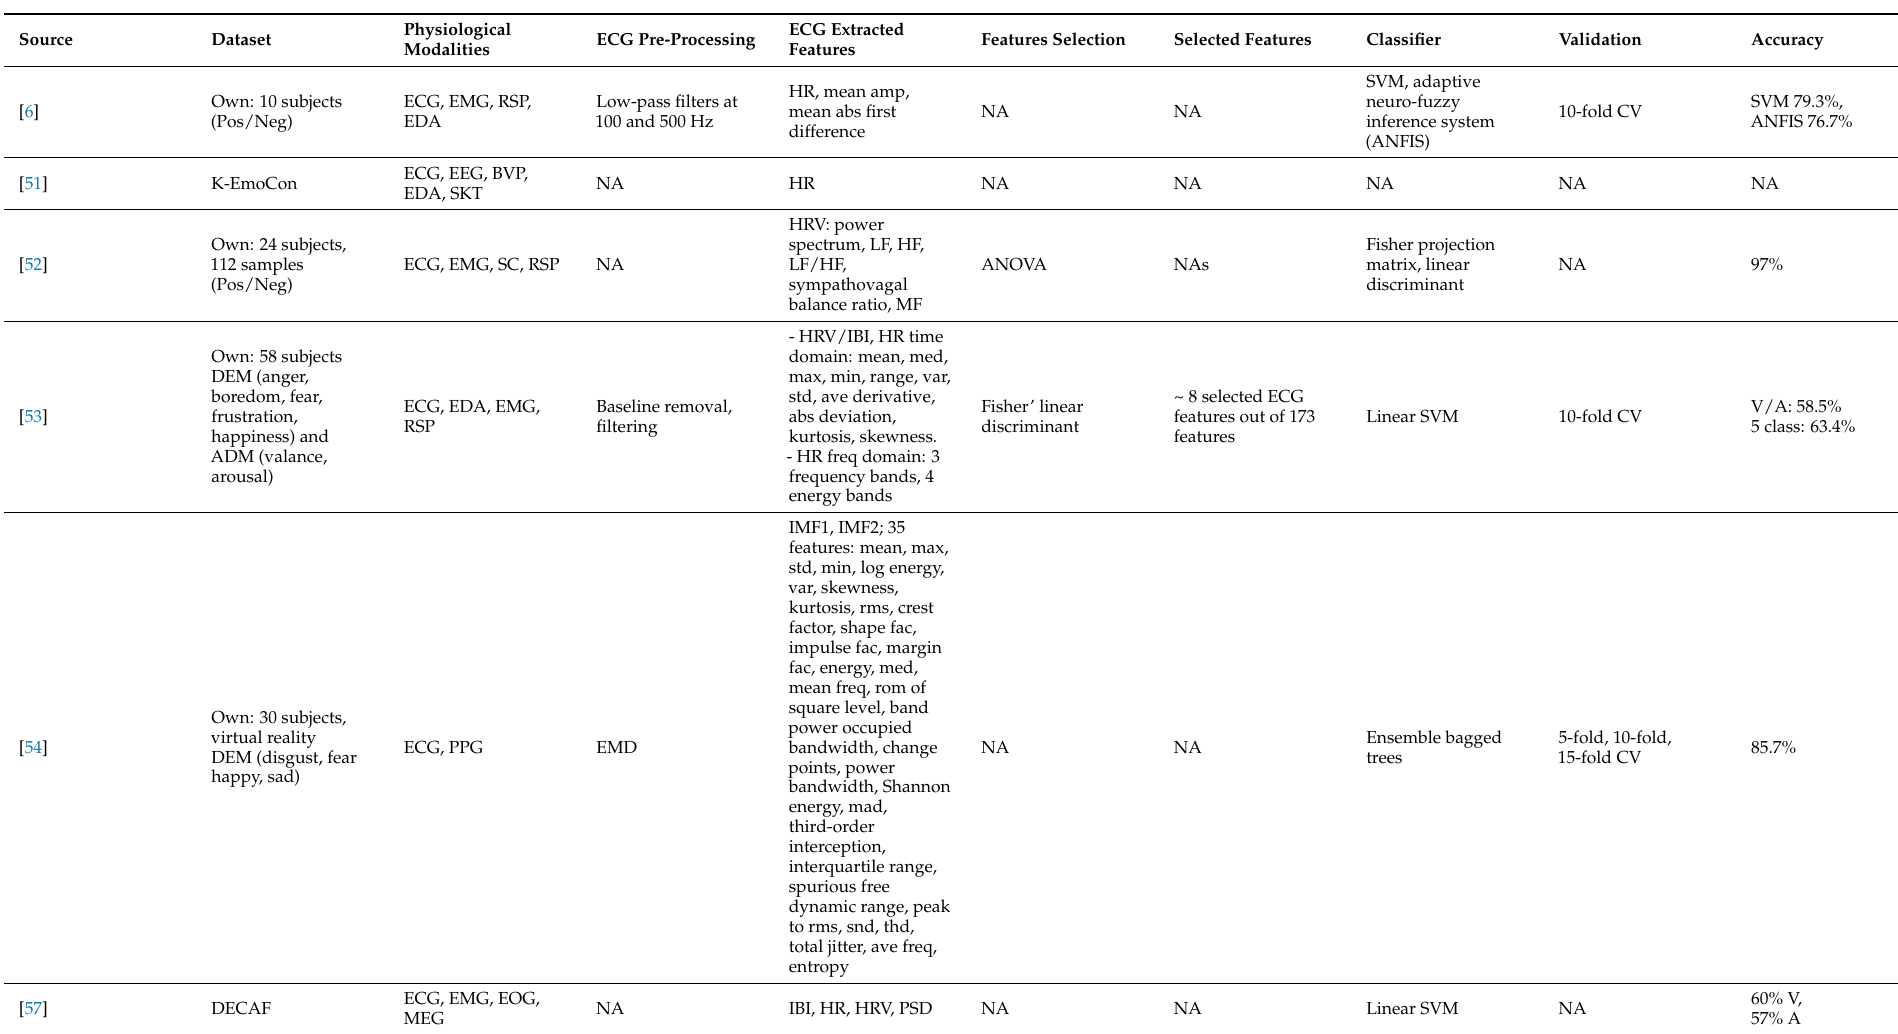
Table 4. Multimodal research that includes ECG model but did not perform an independent classification for the